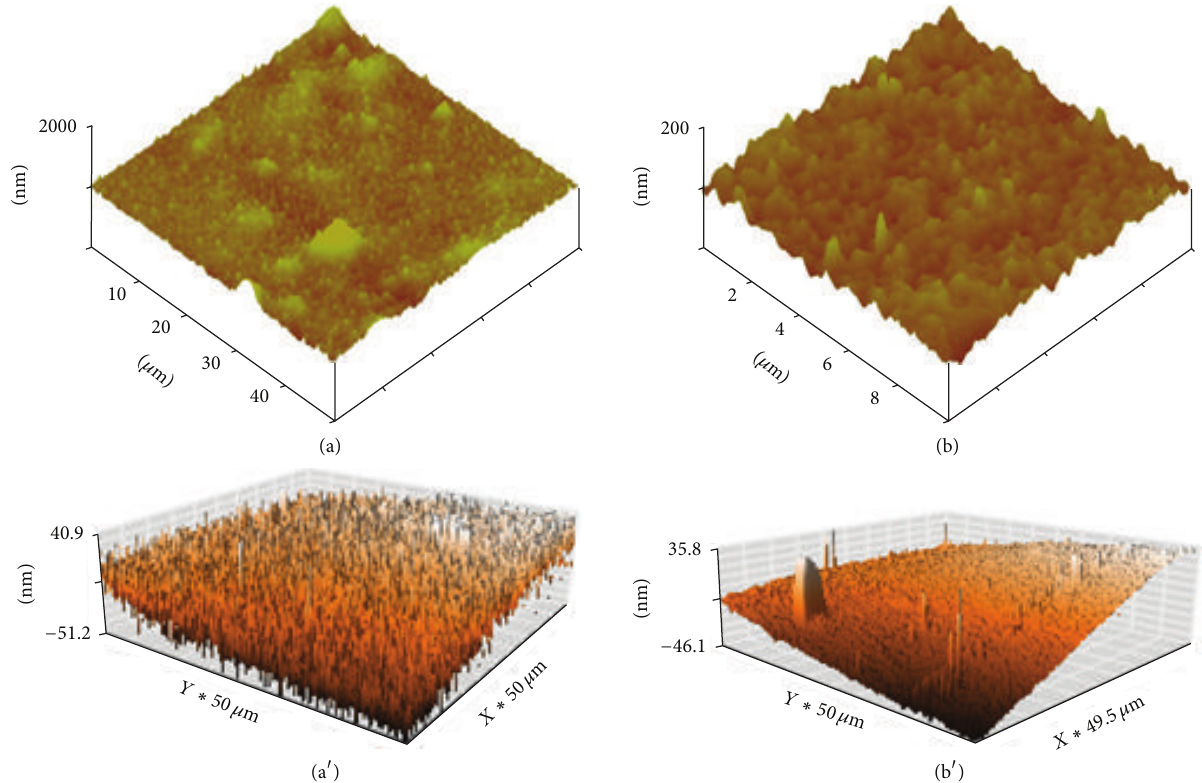
Figure 5: AFM micrographs of film copolymers (a) P1 and (b) P2 fabricated by drop casting from toluene solutions and (a 󸀠 ) P1 and (b 󸀠 ) P2 prepared by spin coating from chloroform